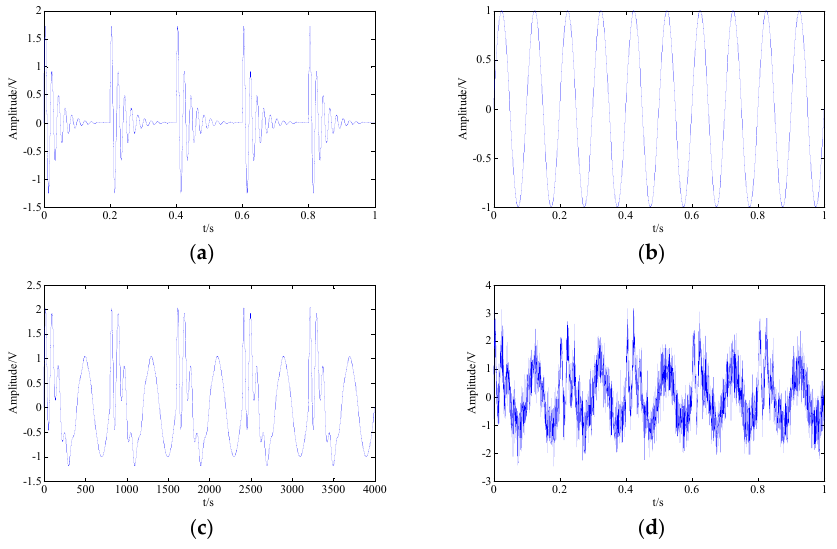
Figure 4. The time response of different components: ( a ) original shock signal in time-domain; ( b ) original harmonic signal in time-domain; ( c ) composite signal without noise in time-domain; and ( d ) composite signal with noise in time-domain.